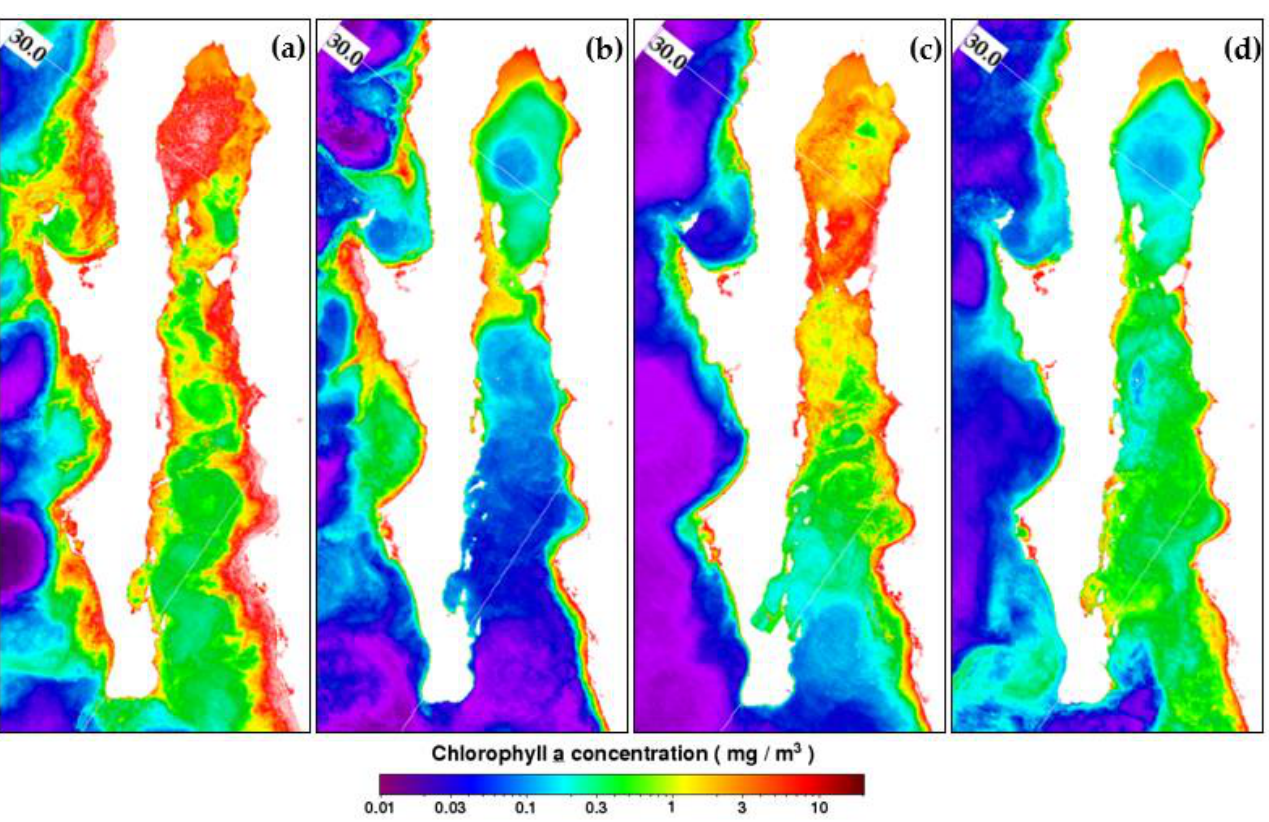
Figure 6. Variability of Chl a concentration during March and August 2011 ( a , b ) (La Niña), where high concentration ca be observed along the western coast of the Baja California Peninsula (South Californian Pacific) and in the Gulf of California for March, contrary to August where a clear decrease is observed. However, ( c , d ) corresponds to the Chl a concentration of March and August 2015 (El Niño) where a significant decrease is observed for the two months along the western coast of the Baja California Peninsula (South Californian Pacific) and in the Gulf of California in comparison with 2011. This general pattern describes the variability of Chl a concentration observed in the time series (Figure 4) and time series anomalies (Figure